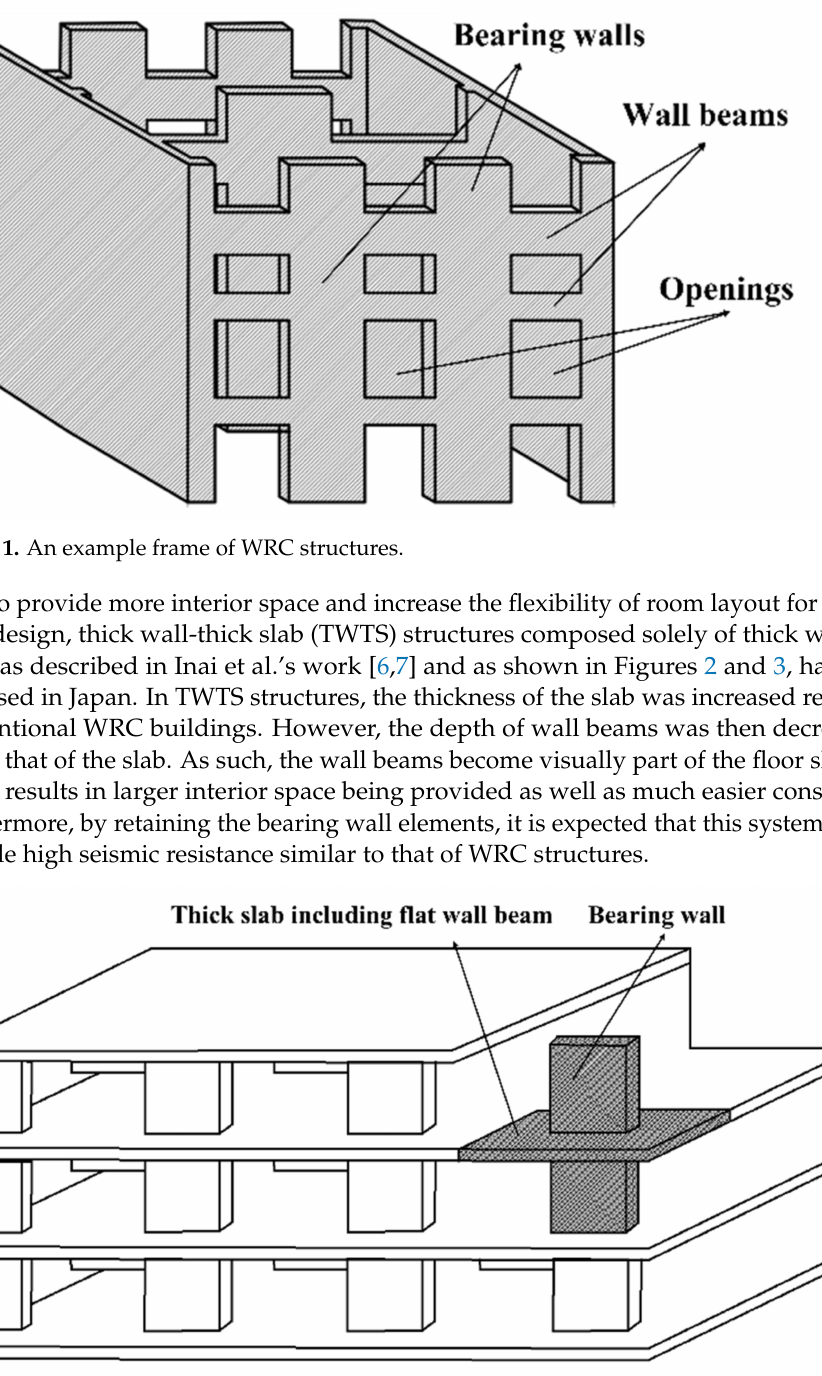
Figure 2. Thick wall-thick slab building